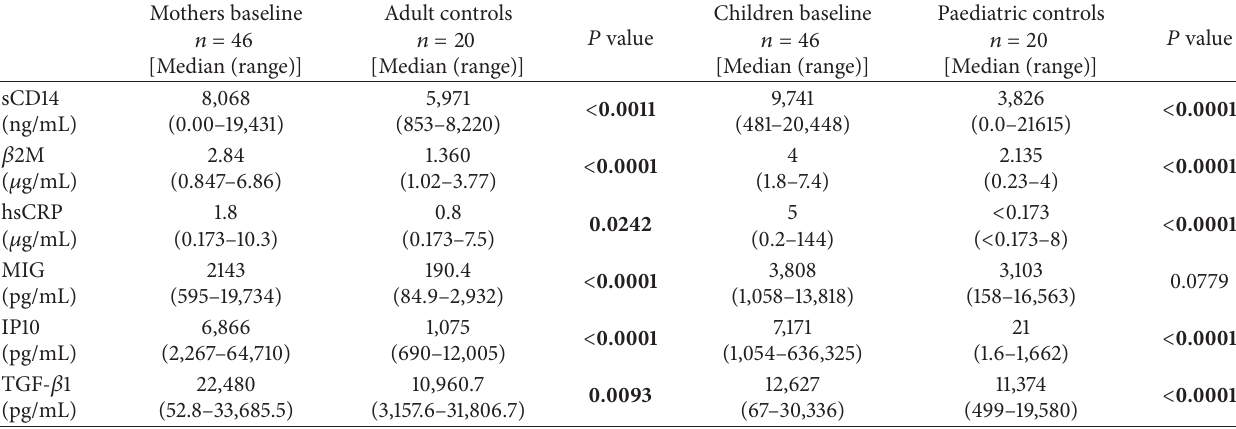
Table 2: Comparison of the concentrations of circulating biomarkers of immune activation of mothers, their children, and their respective controls.